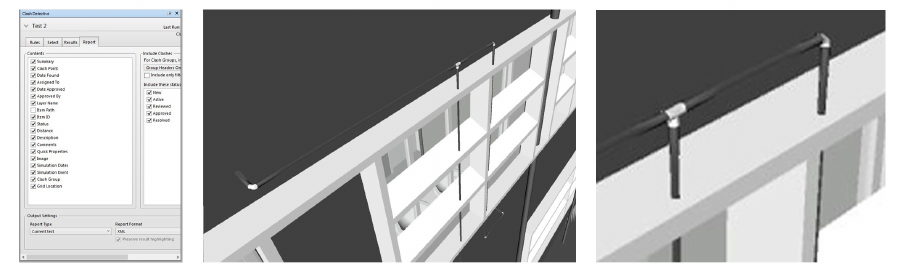
Figure 2. Intersection conflicts through the coordination of the construction